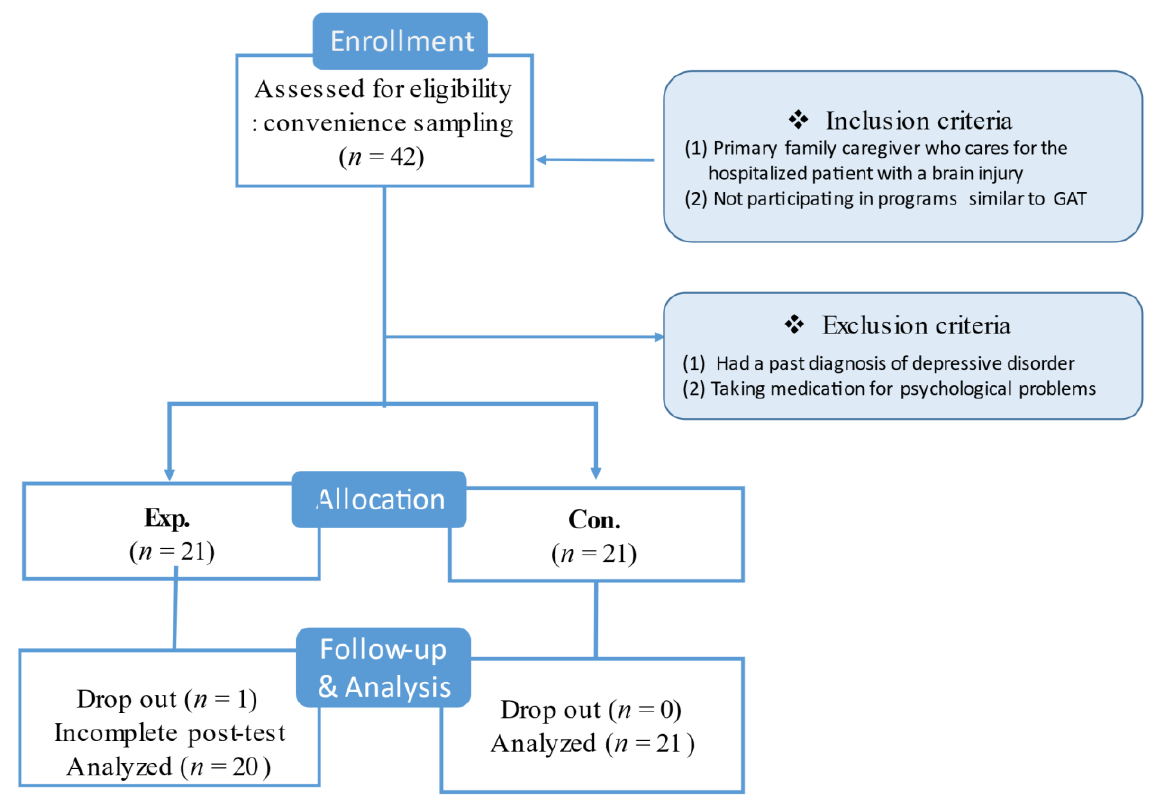
Figure 2. Study design. GAT refers to group art therapy.